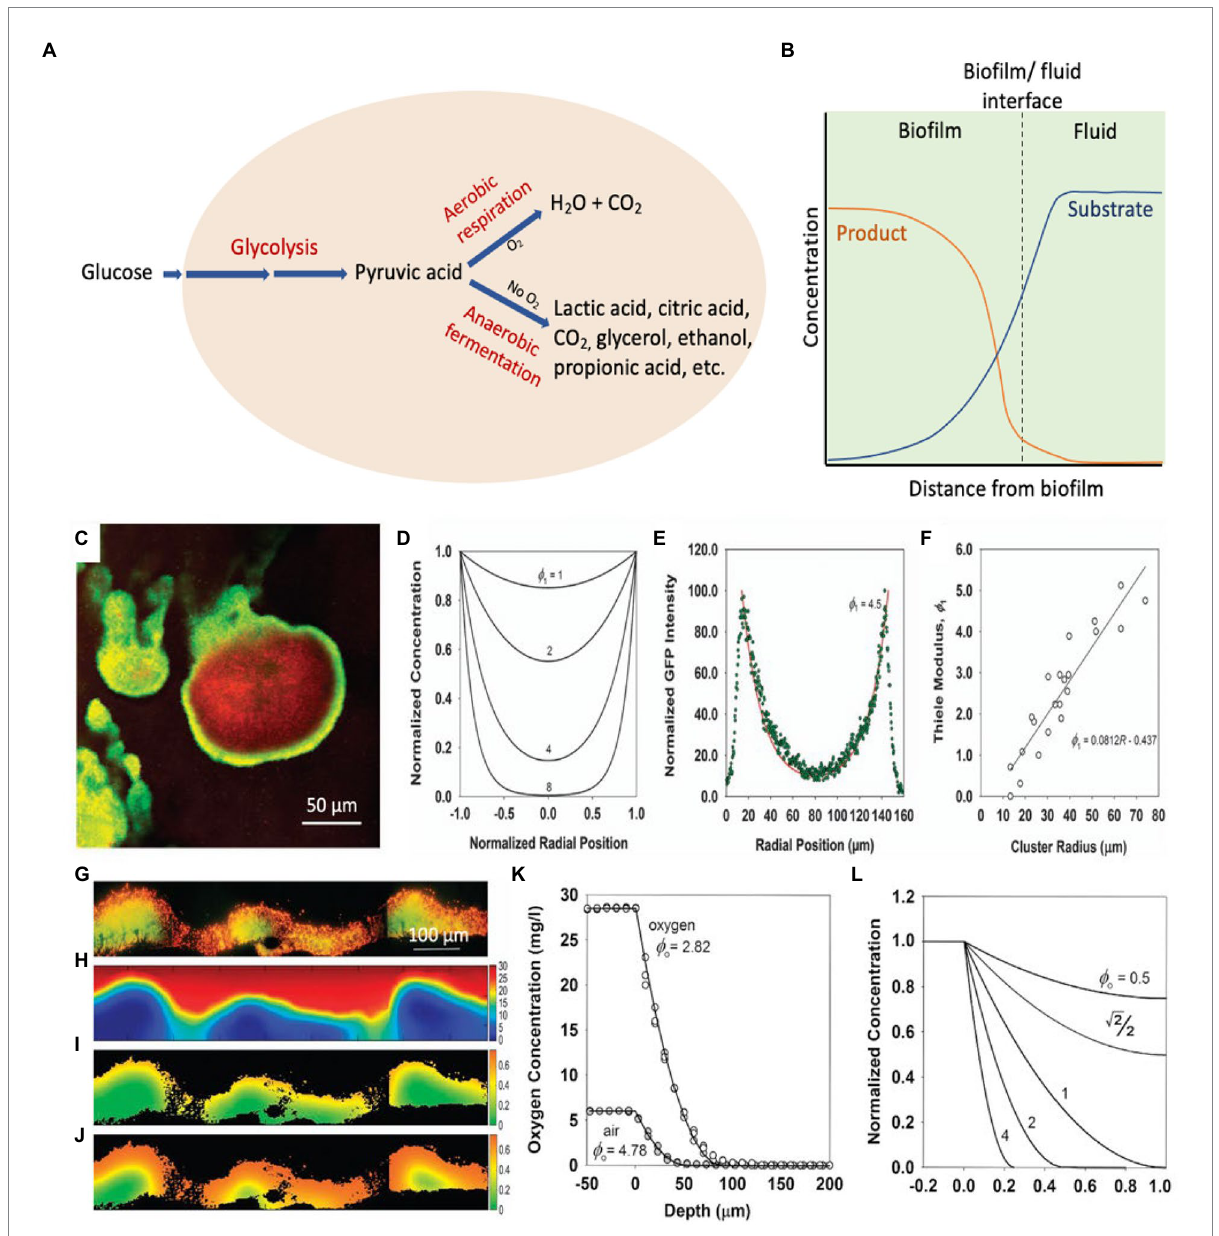
FIGURE 3 Mechanisms of local acidosis and hypoxia with the comparison between reaction–diffusion simulations and experiments. (A) Schematic diagram of cellular glucose metabolic pathways resulting in acidic metabolites. (B) Concentrations of the metabolic substrate and metabolic product with distance from the biofilm. (C) The pattern of GFP expression (green) and biomass counterstain (red) in a cell cluster demonstrating a growth rate gradient within a biofilm. The scale bar represents 50 μ m (Stewart et al., 2016). (D) Calculated concentration profiles of a substrate in a hemispherical cluster for varying values of the Thiele modulus, ϕ 1 under first-order reaction kinetics (Stewart et al., 2016). (E) Fit of a theoretical curve ( ϕ 1 = 4.5) fitted to an experimental GFP intensity (Stewart et al., 2016). (F) Determination of Thiele modulus by fitting experimental data versus cluster radius (Stewart et al., 2016). (G) The relative growth rate of a biofilm using acridine orange-stained frozen section (red/orange represent regions of relatively rapid growth; green/yellow regions represent slow growth). The scale bar represents 100 μ m (Wentland et al., 1996; Stewart et al., 2016). (H) Simulated glucose concentration in mg L − 1 (bulk fluid glucose concentration of 30 mg L − 1 ; Stewart et al., 2016). (I) Simulated growth rate in h − 1 (bulk fluid glucose concentrations of 10 mg L − 1 ; Stewart et al., 2016). (J) Simulated growth rate in h − 1 (bulk fluid glucose concentrations of 25 mg L − 1 ; Stewart et al., 2016). (K) Experimental oxygen concentration profile in a biofilm (gray circles – exposed to air, open circles – exposed to oxygen- enriched gas, solid lines – theoretical curves fitted to two data sets; Stewart et al., 2016). (L) Theoretical concentration profile for a metabolic substrate with varying values of Thiele modulus, ϕ o, under zero-order reaction kinetics (Stewart et al., 2016). These figures were reproduced with permission from Stewart et al. (2016) and Wentland et al.